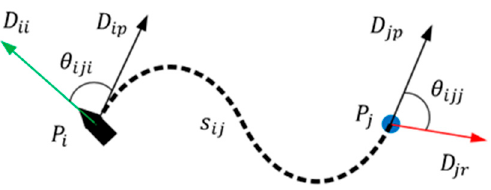
Figure 1. The time cost is affected by the length s ij of the planned path, the angle θ iji at the initial point and the angle θ ijj at the target point.